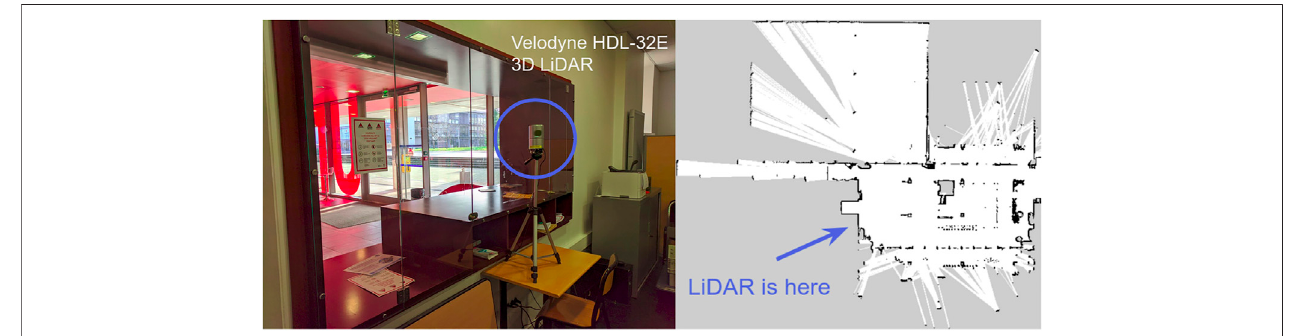
FIGURE 4 | Left: a Velodyne HDL-32E 3D LiDAR placed in the reception near the UTBM building door. Right: the occupancy map built by a Toyota HSR robot (Yamamoto et al., 2019) with a Hokuyo UST-20LX 2D LiDAR.